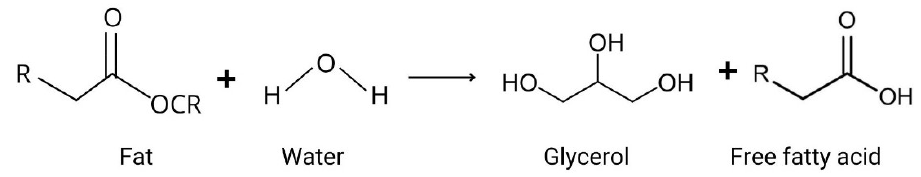
Figure 3. Fat hydrolysis reaction.